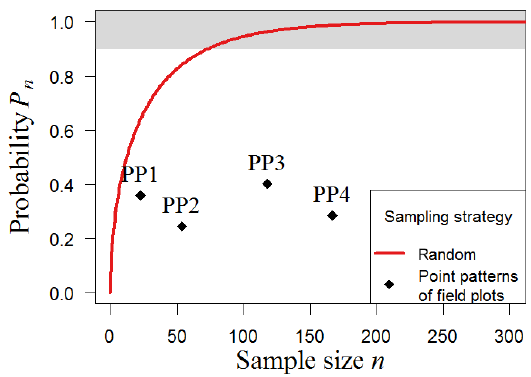
Figure 6. Clustered sampling of biomass in South America. We tested different clustered sampling strategies using reconstructed point patterns based on the locations of existing field plots in South America (PP1–PP4). The simulation was performed with the South America map with a resolution of 500m (25ha plot size). Results show the probability ( P n ) of accurate sampling for the spatial clus- tering of each point pattern (black crosses; ”accurate” means that the mean biomass of the sample does not deviate more than 10% from the mean biomass of the original map). The upper boundary (grey) marks sample sizes with at least 90% chance to estimate biomass accurately. As a reference, the results for random sampling are shown (red